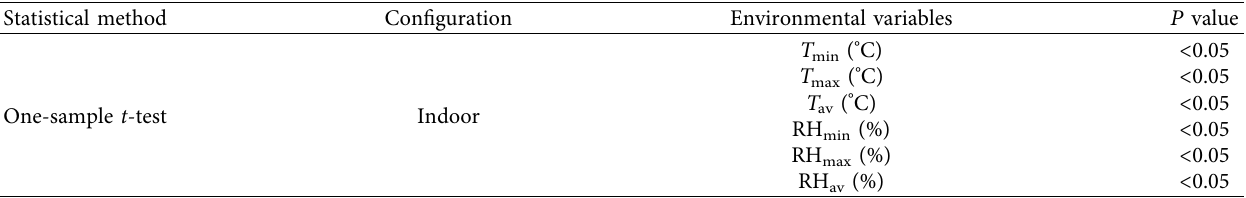
Table 2: One-sample t -test correlations between meteorological factors and COVID-19-infected cases for indoor configuration.